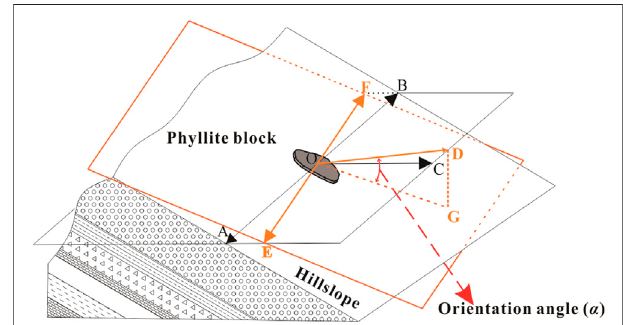
FIGURE 2 | Schematic diagram of the orientation angle ( α ). OE and OF are the strike direction ofthe phyllite block; OA and OB are the strike direction of the bimslope; OD is the dip direction of the phyllite block; OC is the dip direction of the bimslope; OG is the projection of OD on the phyllite bimrock surface plane; orientation angle ( α ) is the angle between the OD and OG